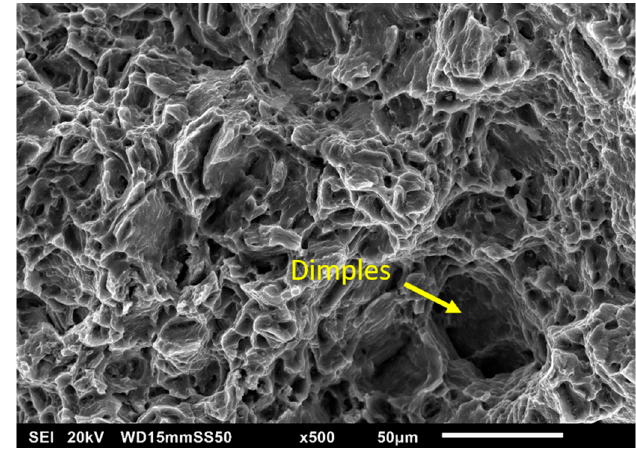
Figure 7. Fractography of as-extruded Mg-2Zn-0.6Ca-1Er .